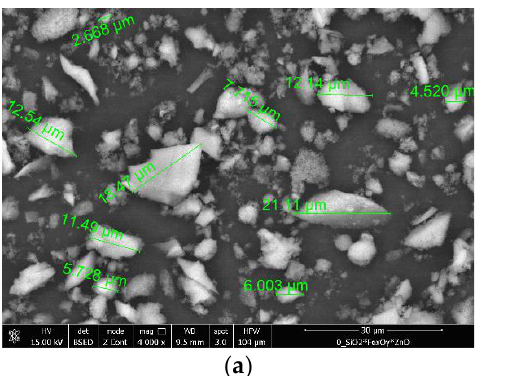
Figure 4. SEM picture recorded for prepared adsorbent material ( a ) and EDX spectra obtained for prepared adsorbent material ( b ).